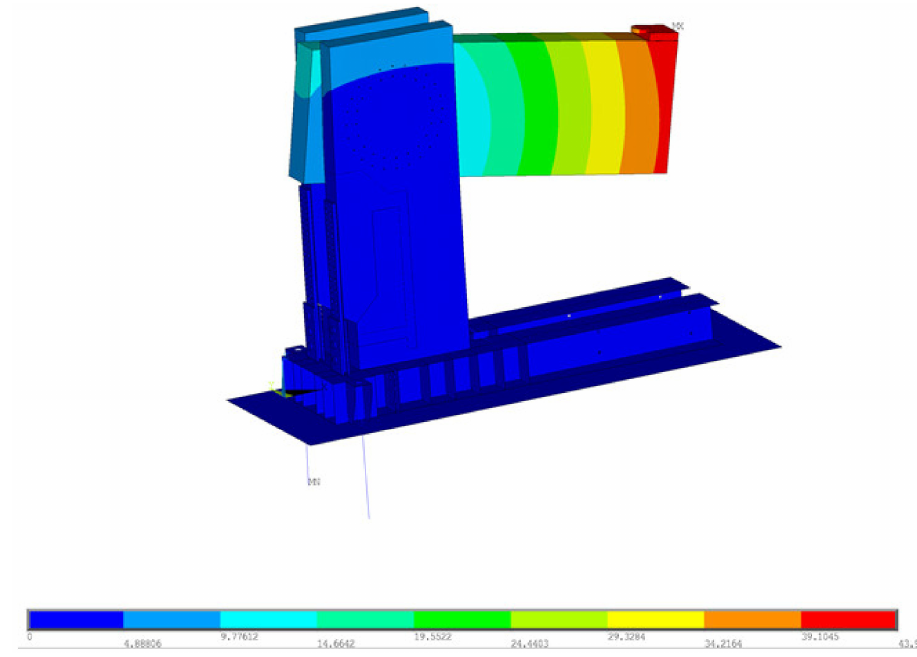
Figure 14. Total deformation of the computational model.